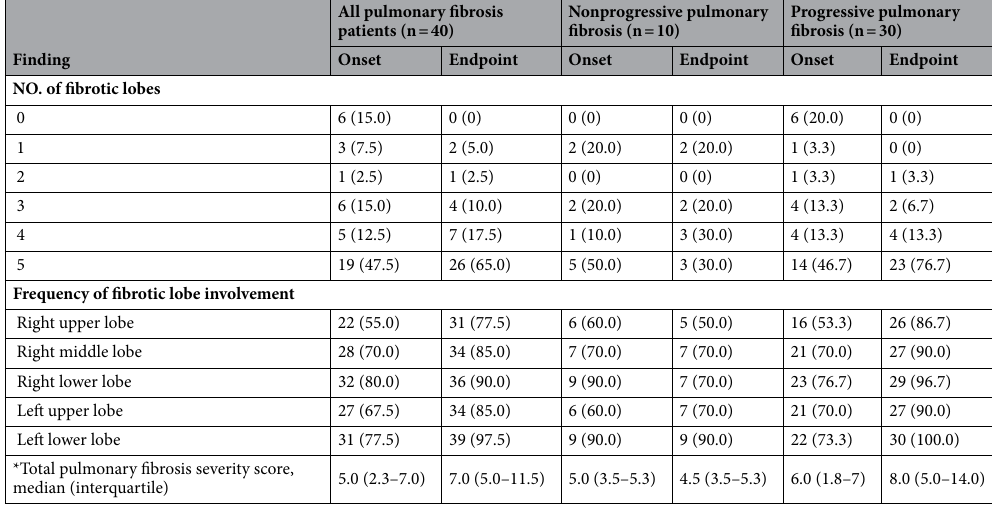
Table 3. Chest CT evaluations of Covid-19 complicated with pulmonary fibrosis patients. Except where indicated, data are cases of patients, with percentages in parentheses. *The corresponding score of each lobe in the five lobes was 0, 1, 2, 3, 4, respectively, and the corresponding affected area was 0, 1–25%, 26–50%, 51–75%, 76–100%, which was referred to the total lung severity score.